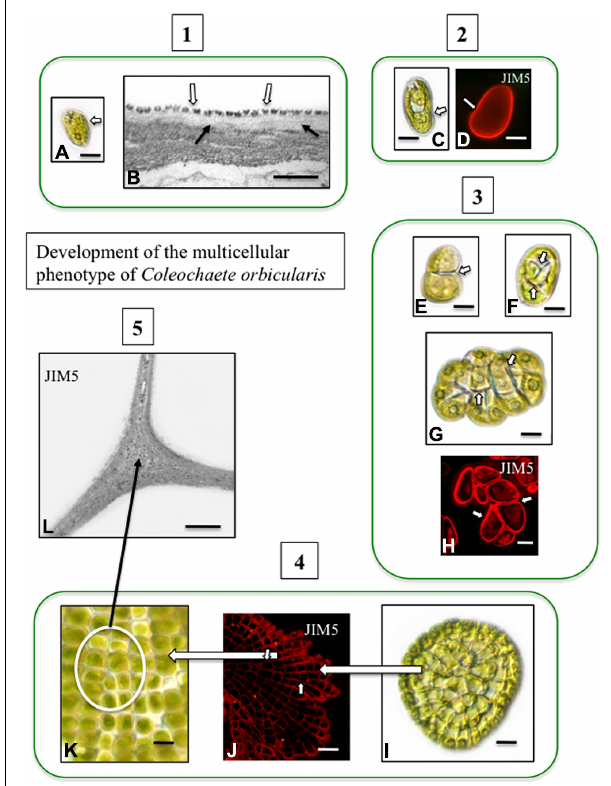
FIGURE 2 | Development of the multicellular phenotype in Coleochaete orbicularis . (1) Unicellular zoospores (A) will swim for several hours before settling down (DICLM; bar = 7 μ m).The plasma membrane of zoospores is covered by a layer of square scales ( B ; hollow arrows). In zoospores that have attached surface, fibrillar cell wall material appears under the scale layer [arrows; transmission electron microscopy (TEM) image bar = 500 nm]. (2) After settling down, a cell wall quickly forms on each zoospore ( C : DICLM; bar = 5 μ m).The wall labels with the monoclonal antibody, JIM5, with specificity for relatively low esterified HG [ D ; arrow; confocal laser scanning microscope (CLSM) image; bar = 4 μ m]. (3) During intermediate stages of development, the walled cell divides into a 2-cell stage ( E , arrow; bar = 3 μ m), a 4-cell stage ( F ; arrows; bar = 4 μ m) and an 8-cell stage ( G , arrows; bar = 6 μ m). Images ( E–G) are DICLM images.The cell walls of each cell of these multicellular stages (arrows) label with JIM5 ( H , arrows; CLSM; bar = 3 μ m). (4) Late stages of multicellular development.The mature thallus consists of several 100 cells organized in a flattened disc ( I ; DICLM; bar = 10 μ m).The cells of this thallus label with JIM5 ( J ; arrows; CLSM; bar = 20 μ m).The individual cells of the thallus are closely packed in the disk ( K ; circle inset; DICLM; bar = 7 μ m). (5)TEM immunogold labeling with JIM5 highlights HG in the walls of cell junctions ( L ; arrows; bar = 500 nm).